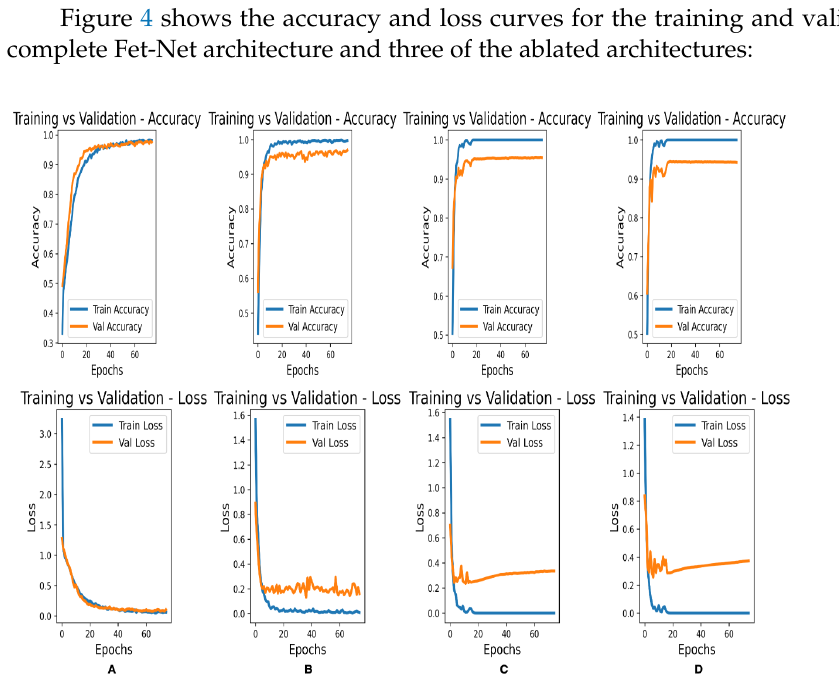
Figure 4. Accuracy and Loss curves for training and validation of the second data-fold for various CNN architectures. ( A ) Complete Fet-Net architecture. ( B ) No dropout in the feature extraction component. ( C ) No dropout in the feature extraction component or classification component. ( D ) No dropout in the feature extraction component or classification component, and no hidden dense layer of 256